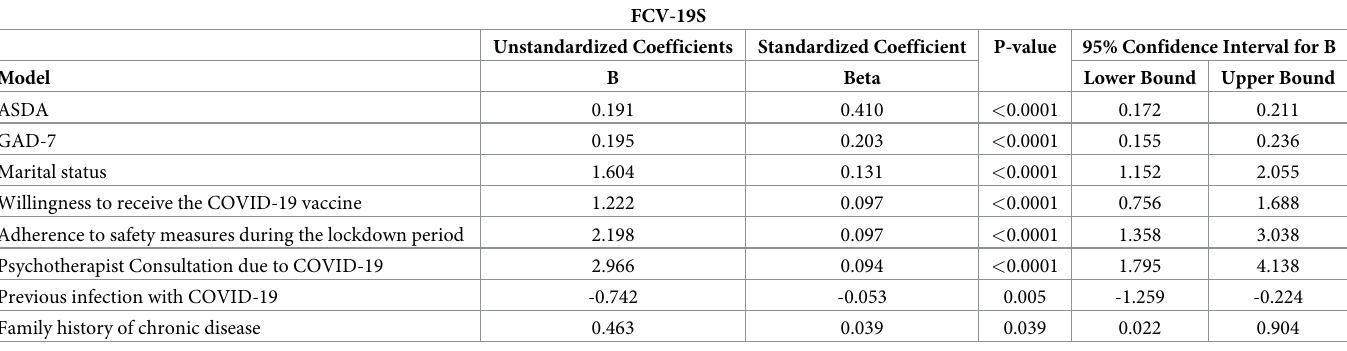
Table 4. Factors associated with the COVID-19 infection